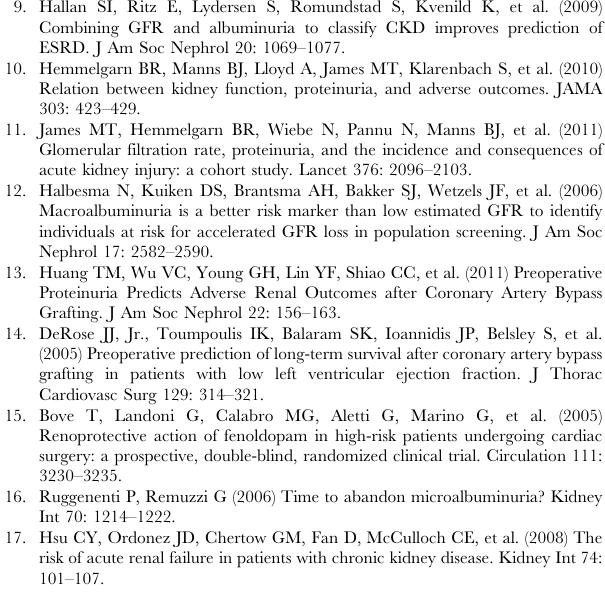
Table S1 Percentage of patients in groups stratified by chronic kidney disease (CKD) stage and proteinuria. Table S2 Factors associated with long- term end stage renal disease (N= 925). Table S3 Factors associated with long- term all- cause mortality (N = 925). Table S4 Factors associated with long- term composite outcome (N =